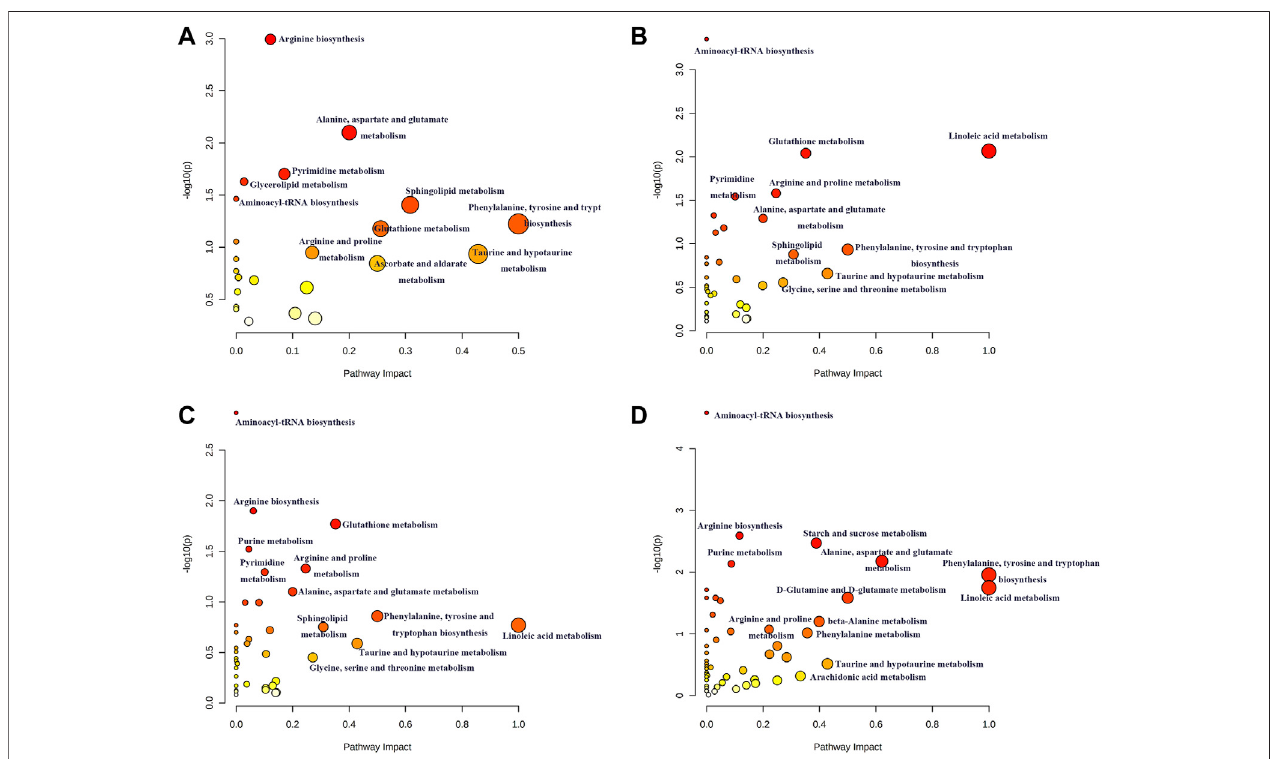
FIGURE 10 | Summary of possible disturbed metabolic pathways involved in ANIT (A) , DDC (B) , EE (C) and LCA (D) groups. The vertical coordinate represents -log( P ) value and the horizontal one represents impact factor. The metabolic pathway with smaller p value and larger impact factor is considered more signi fi cantly relevant with the mechanism